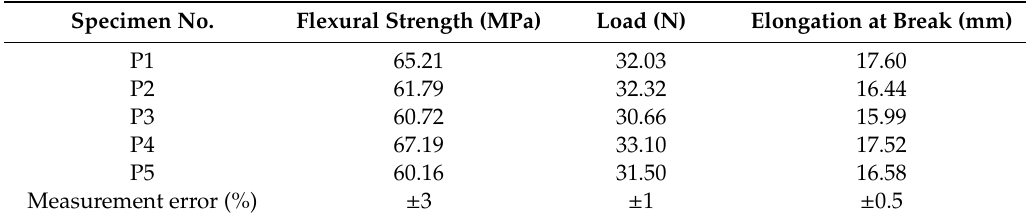
Table 5. Flexural tests for specimens cured at 60 ◦ C for 16 h.